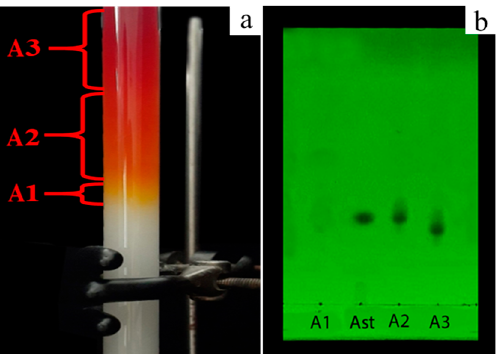
Figure 4. Purification of astaxanthin using silica gel column chromatography ( a ) and TLC analysis of astaxanthin fractions ( b ). A1: fraction 1; A2: fraction 2; A3: faction 3; and Ast: astaxanthin standard.